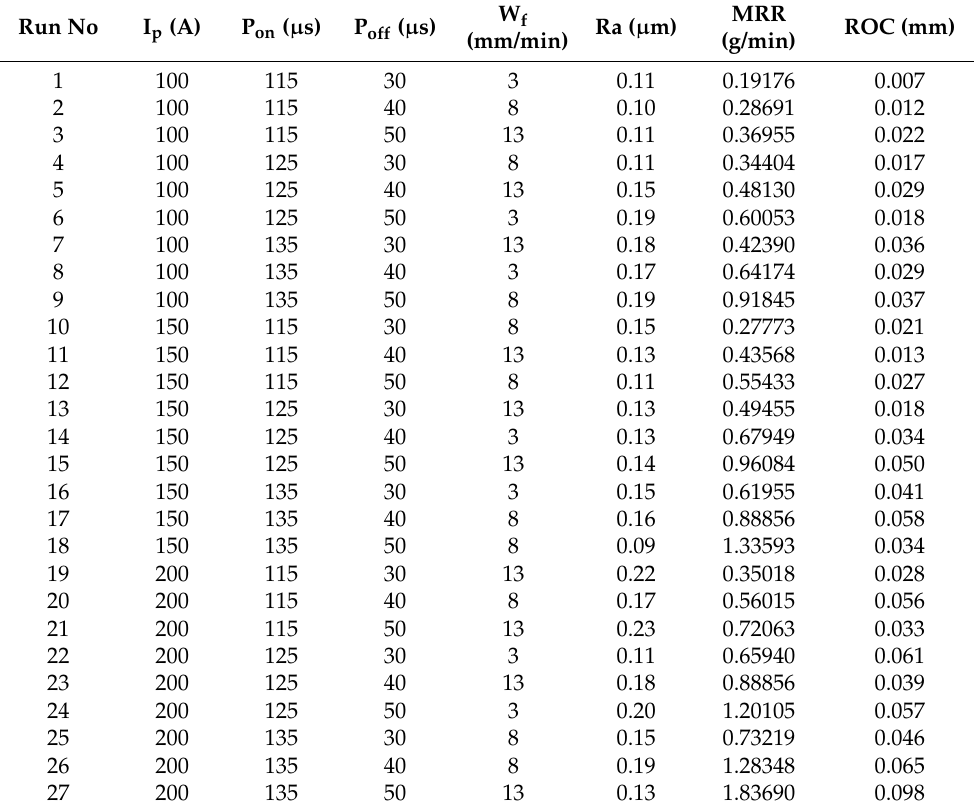
Table 4. Control log of experiment and corresponding